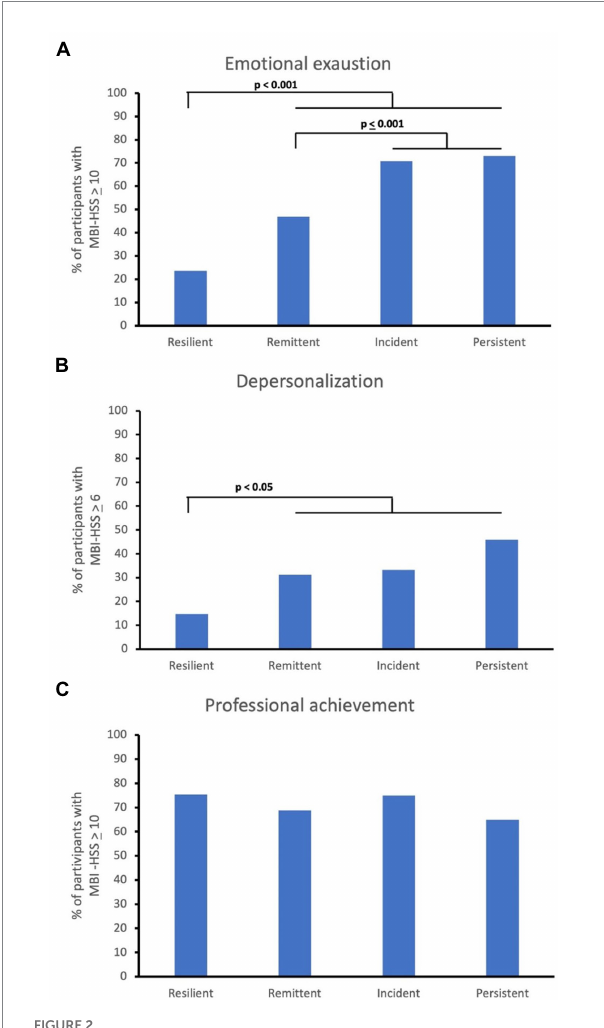
FIGURE 2 Burnout symptoms considering the distribution of individuals according to the anxiety outcome (baseline vs. D450); (A) Emotional exhaustion; (B) Depersonalization; (C) Professional